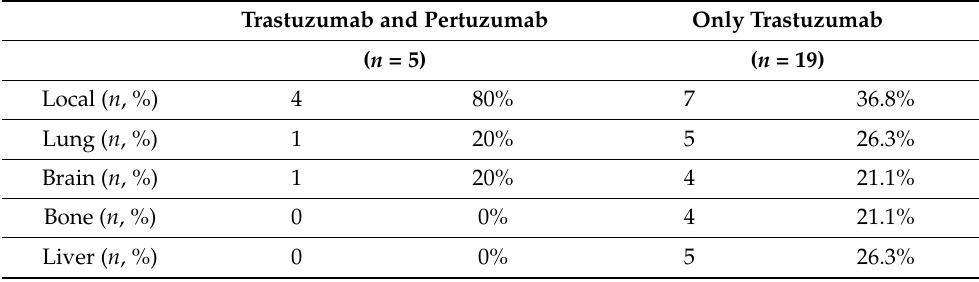
Table 4. Recurrence sites between single-target therapy and dual-target therapy. Some patients had more than one recurrent